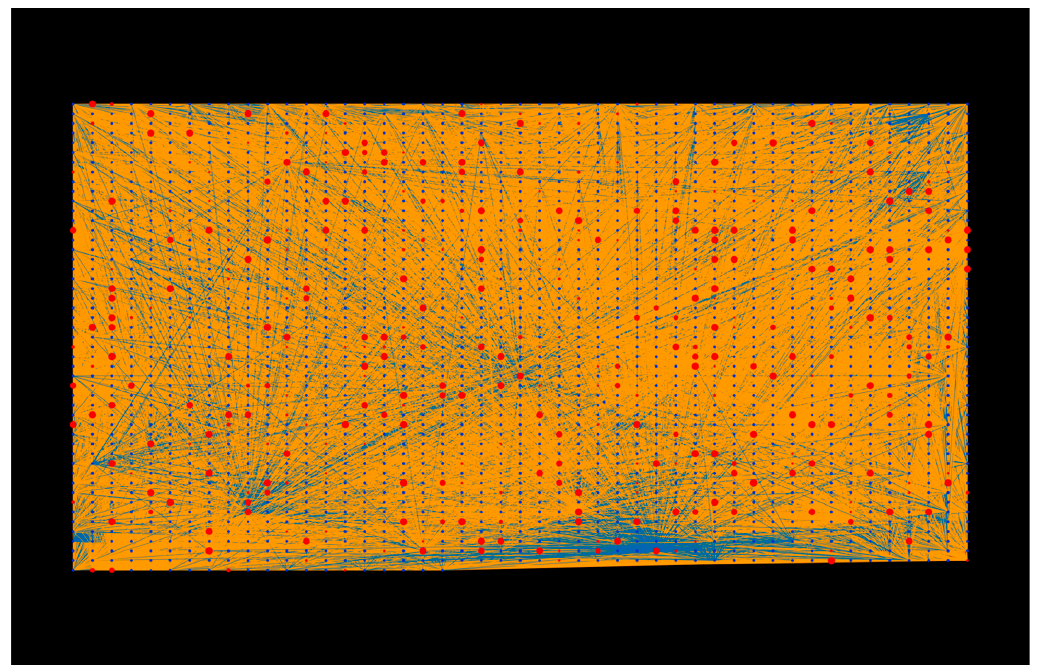
Figure 7. Visualization of the top KEGG pathway (ko04064, NF-kappa B signaling). Blue nodes represent host proteins, red nodes are pathogen proteins. Orange edges depict the interactions from the interolog-based approach, while blue edges belong to the domain-based approach.